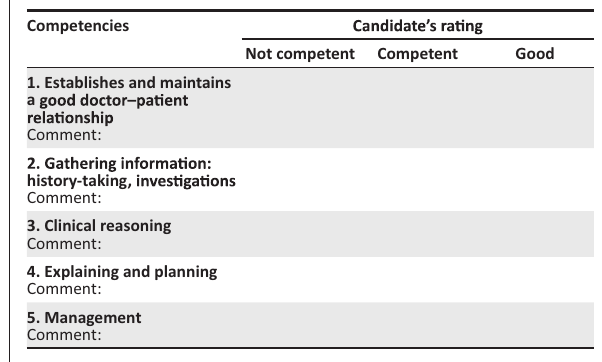
FIGURE 1: Marking sheet for objectively structured clinical examination station